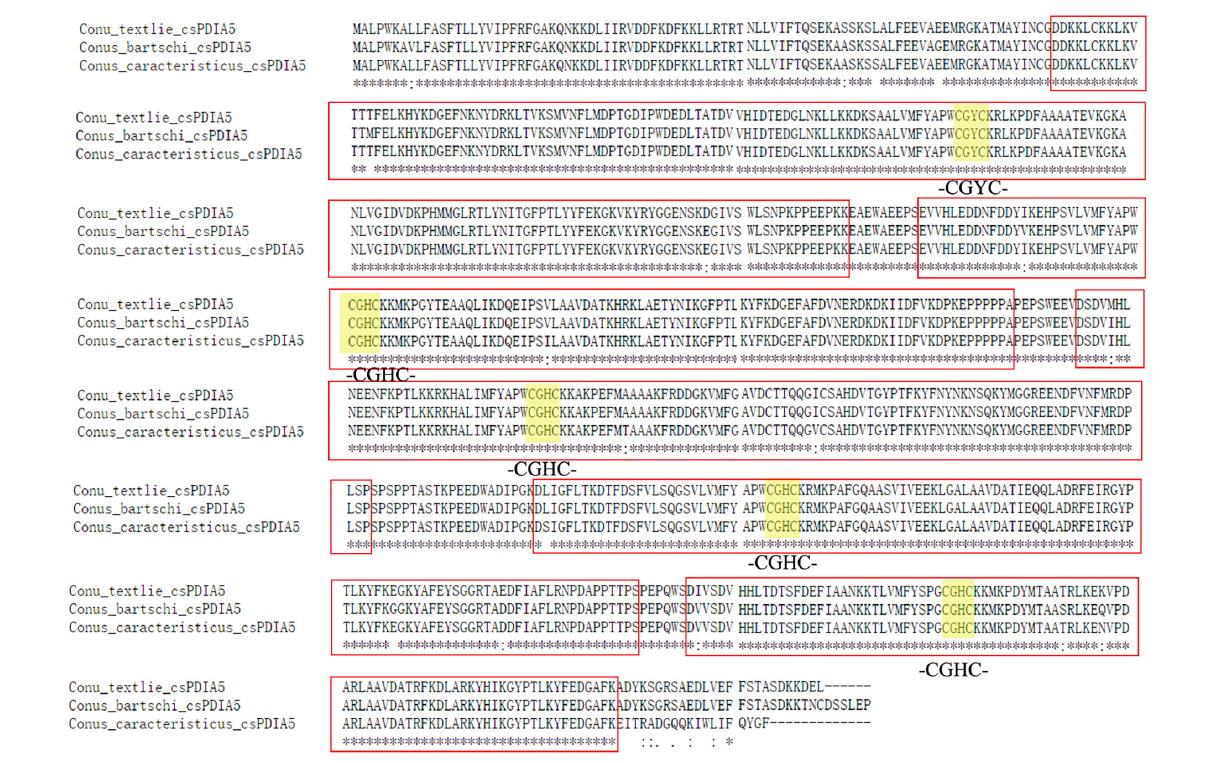
FIGURE 5 | Sequence analysis of csPDIA5 from C onus textile, C . caracteristicus, and C .